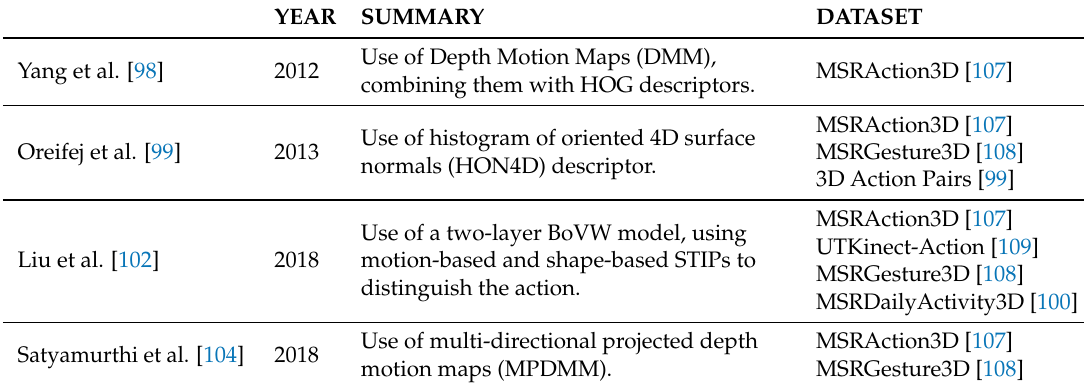
Table 2. Summary of depth information based